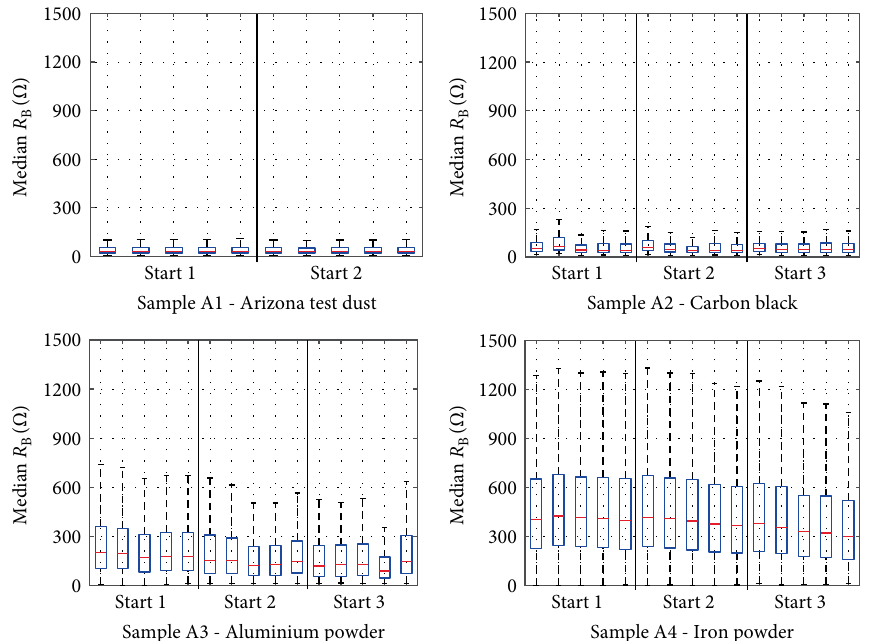
Figure 11: The value of 𝑅 for different particle types at a concentration level of 150 mg/L. The median value of R 𝐵 Sample A3 and A4, while it is relatively stable for Sample A1 and